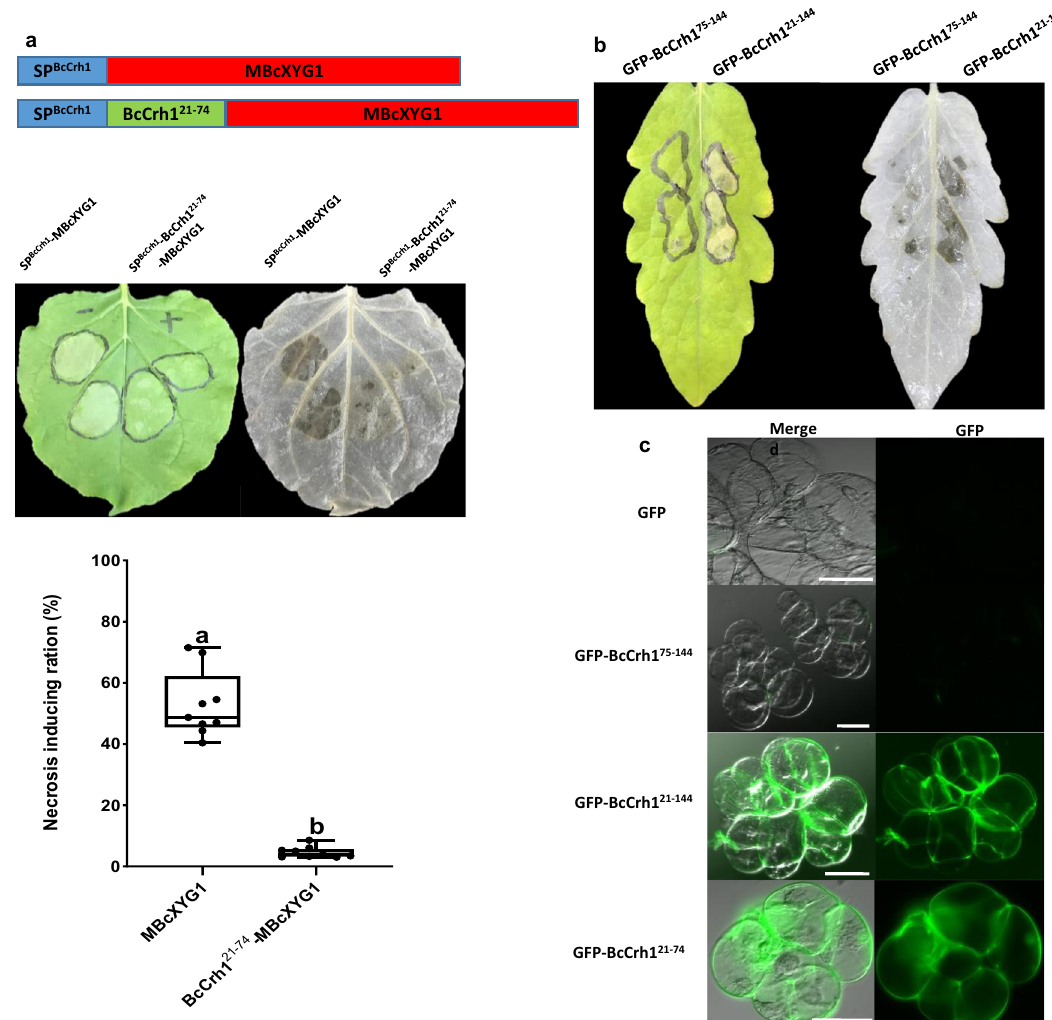
Fig. 3 A stretch of 53 amino acids at the N ′ end of the protein mediates uptake of BcCrh1 by plant cells. Following analysis of a series of deletion constructs, a minimal region suspected of being necessary for protein uptake was de fi ned. a To test the delivery of heterologous proteins using the putative translocation signal, we generated two expression constructs with enzymatic inactive version of the apoplastic NIP BcXYG1 (MBcXyg1) (Zhu et al. 5 ). Blue — BcCrh1 SP, Red — MBcXyg1, Green — the suspected delivery sequence. Middle left — images of N. benthamiana leaves three days after Agroin fi ltration. Leaves were bleached with ethanol (right images) and the necrotic area was calculated. Center lines of the boxplots show the medians, box limits indicate the 25th and 75th percentiles; whiskers cover the full range of values; all data points are plotted as black dots. Data are from 10 sample points from three independent biological replications. Different letters indicate statistical differences at P ≤ 0.001 ( P = 6.05e − 10) according to unpaired two-tailed Student ’ s t -test. b Images of tomato leaves 48 h after in fi ltration with 11 μ M of puri fi ed BcCrh1-derived peptides, BcCrh1 75 – 144 and BcCrh1 21 – 144 . c Tomato cell cultures (MsK8) were incubated for 18 h with 5.5 μ M solution of GFP-tagged peptides (GFP-BcCrh1 75 – 144 , GFP-BcCrh1 21 – 144 , and GFP-BcCrh1 21 – 74 ), washed three times and visualized by a confocal microscope. Bars = 50 μ m. The experiments were repeated three times with similar